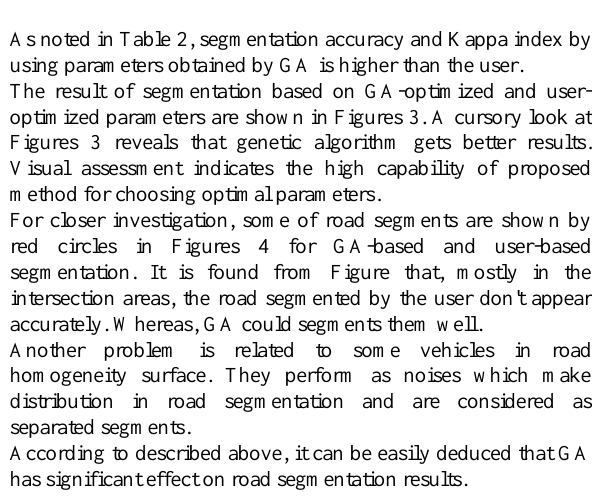
Table 2.Overall accuracy and Kappa Index for GA-based and user-based